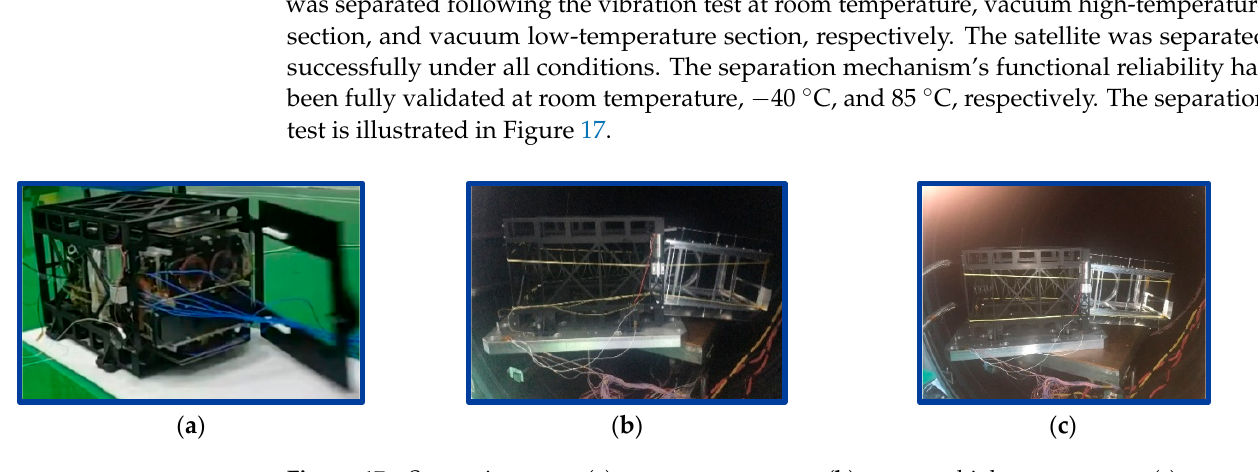
Table 9. Results of random vibration test.